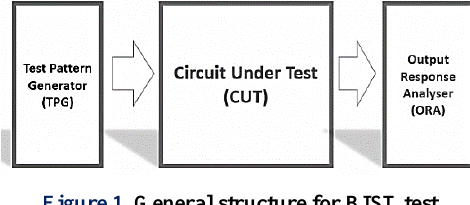
Figure 1. General structure for BIST